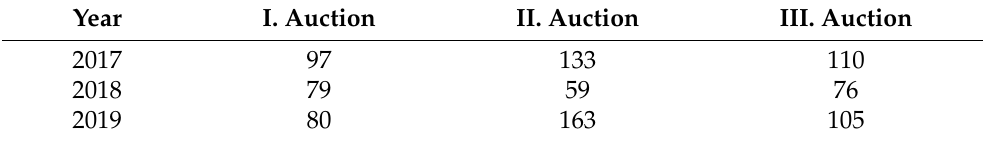
Table 4. Number of participants on the German PV auctions, in 2017, 2018 and 2019, source: [44].